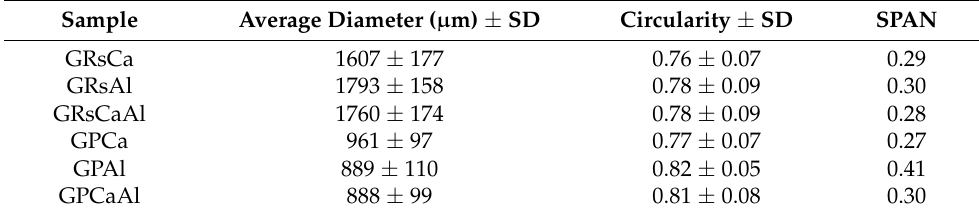
Table 2. Microparticle average diameter, circularity, and SPAN index (n =